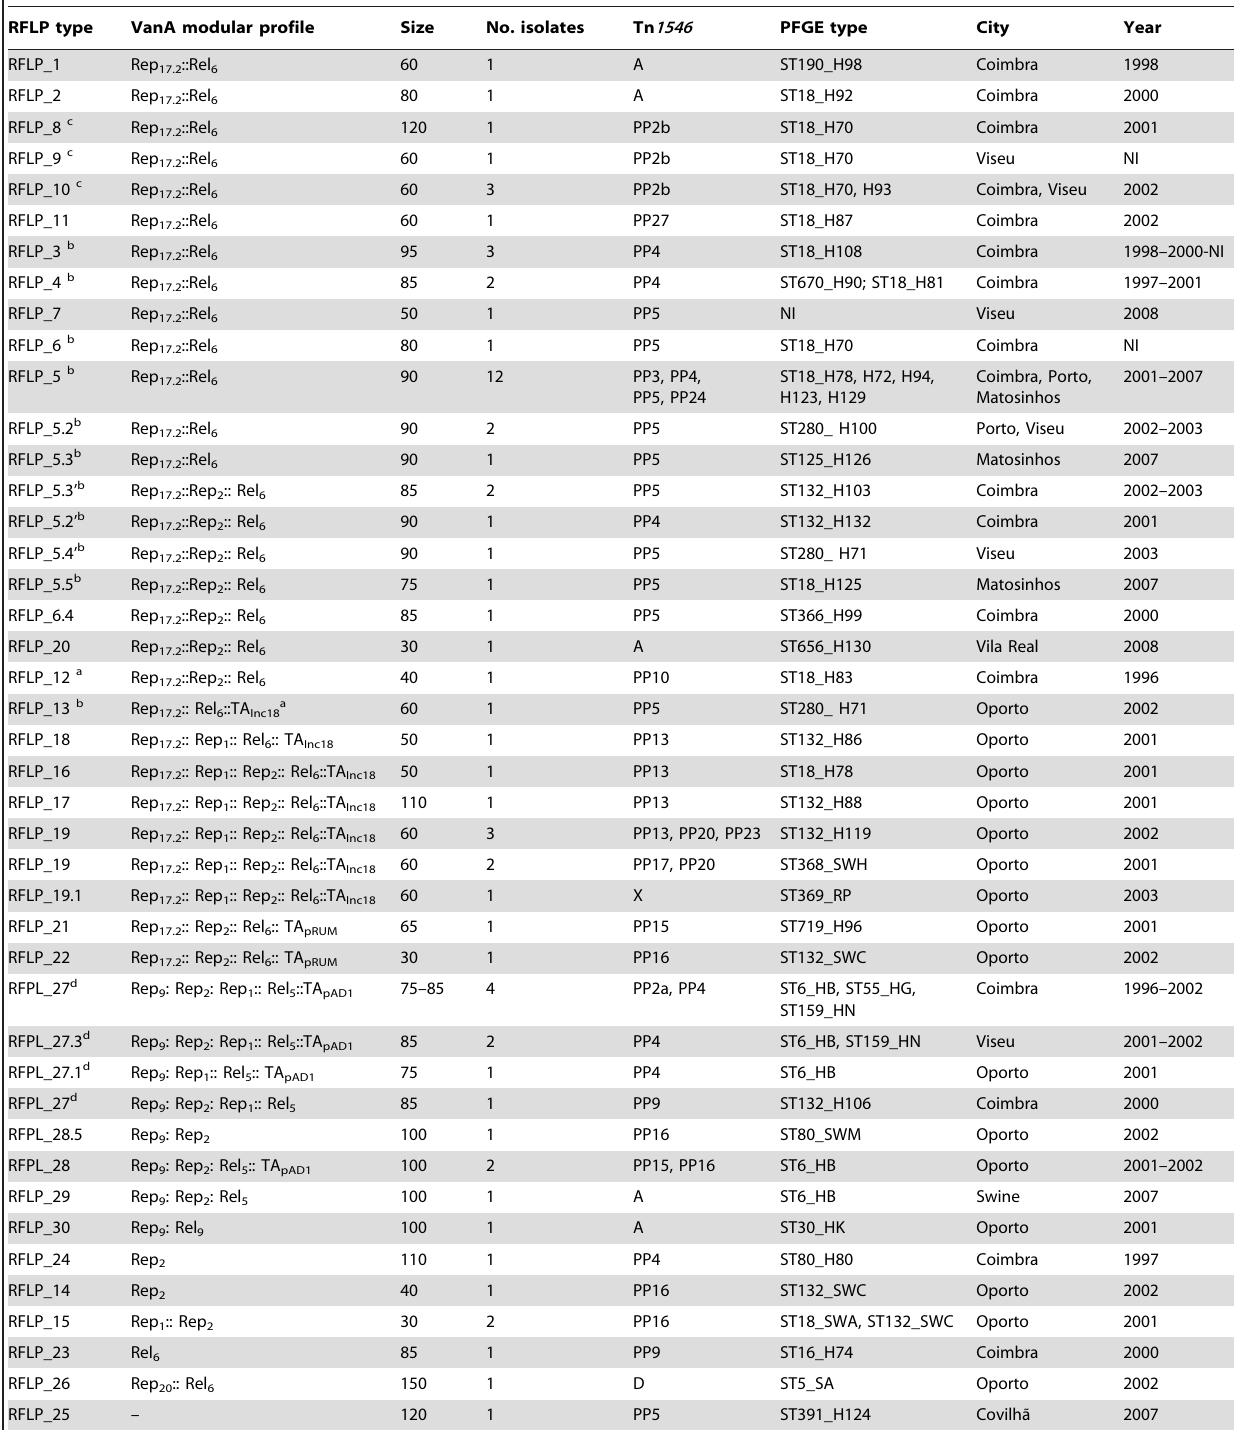
Table 1. Plasmids identified in this